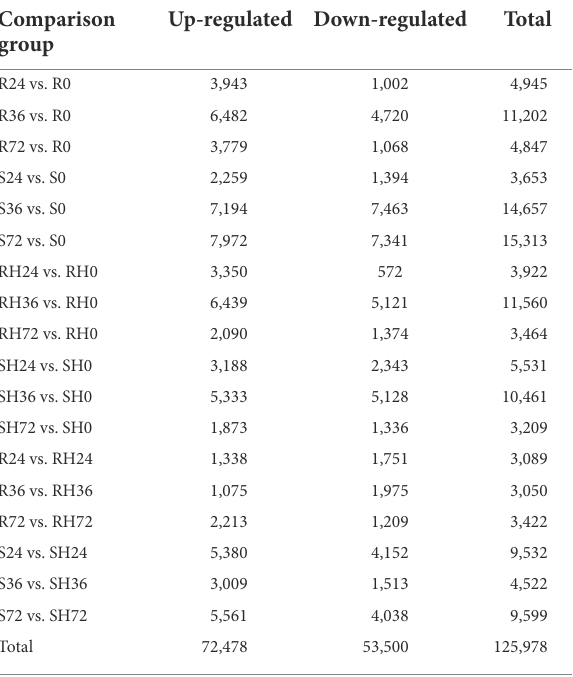
TABLE 1 The number of DEGs in different comparison